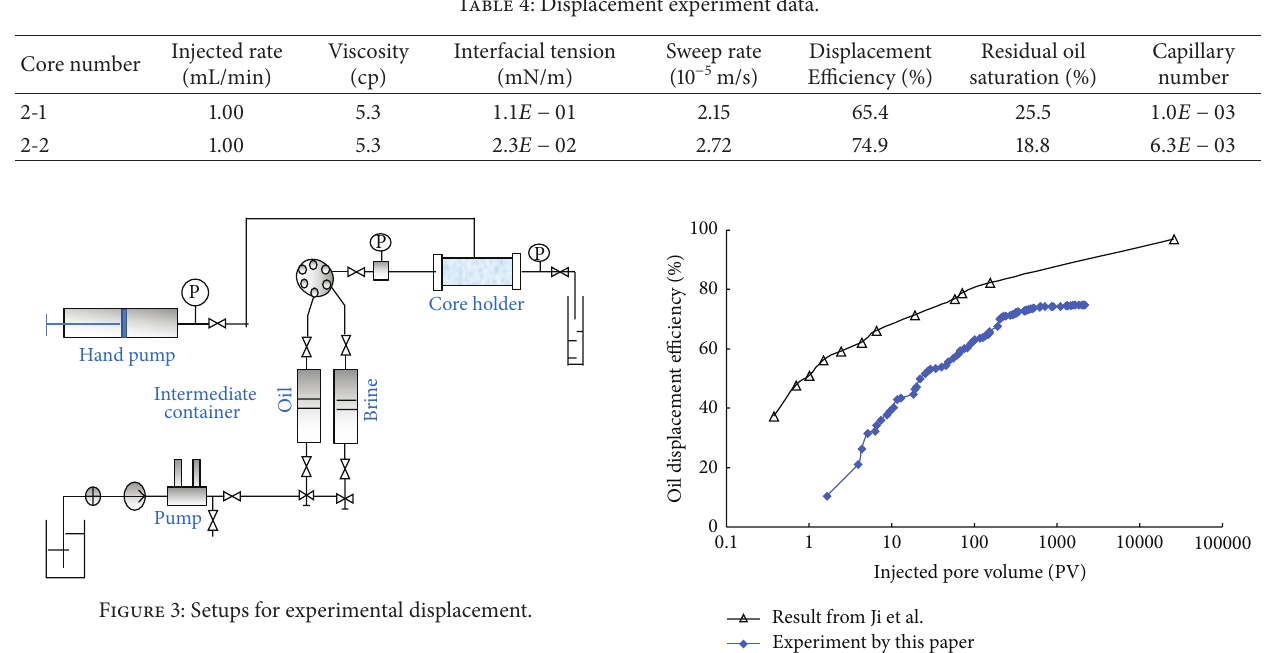
Figure 4: Comparison of the result with experiment by Ji et al. [13]. In Ji’s experiment, the core with 2413 mD permeability was from Daqing Oilfield of China and the injected water reached 30,000 PV.